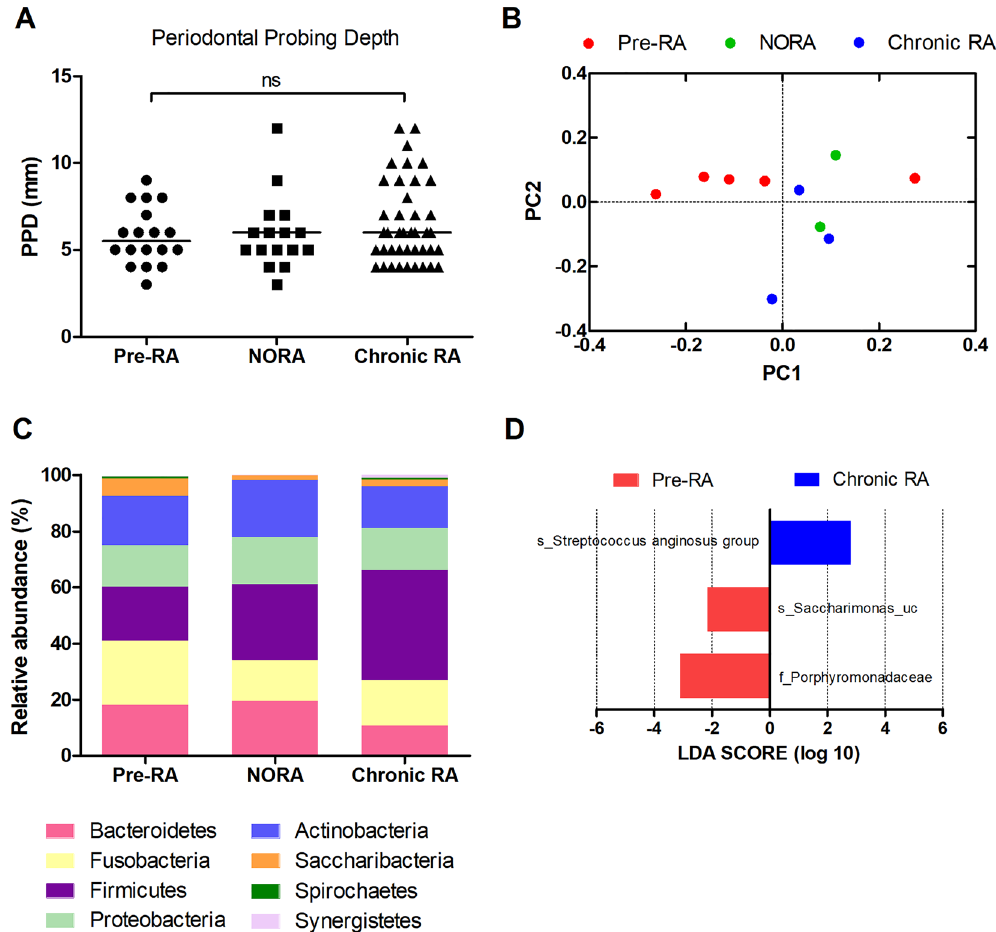
Figure 1. Periodontitis and the subgingival microbiome in patients with preclinical rheumatoid arthritis (pre-RA), new-onset RA (NORA), and chronic RA. ( A ) Comparison of periodontal probing depth (PPD) among patients with pre-RA, NORA, and chronic RA (ns: not significant, Kruskal-Wallis test). ( B ) Beta diversity of the subgingival microbiome between different RA statuses is represented by principal coordinates analysis (PCoA) plot using UniFrac distance matrix ( p = 0.388, PERMANOVA). ( C ) Comparison of subgingival microbial composition at the phylum level among patients with pre-RA, NORA, and chronic RA (Kruskal- Wallis test). ( D ) Linear discriminant analysis effect size (LEfSe) analysis identifies differentially abundant taxa among patients with pre-RA, NORA, and chronic RA. Red bars and a blue bar indicate taxa abundant in pre-RA and chronic RA groups,